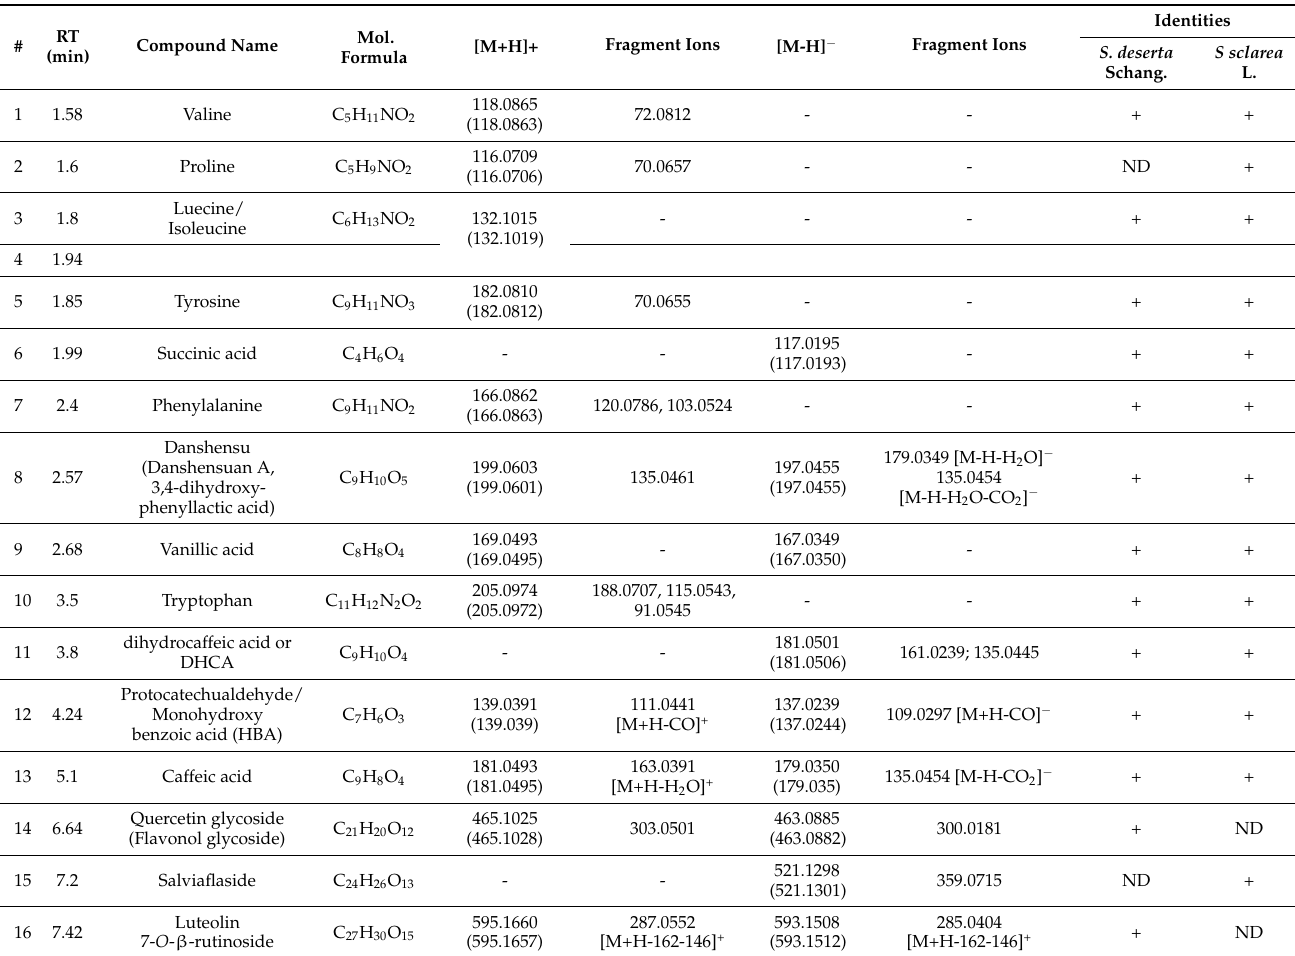
Table A1. Chemical profiling of LS-2 and LS-4 extracts using